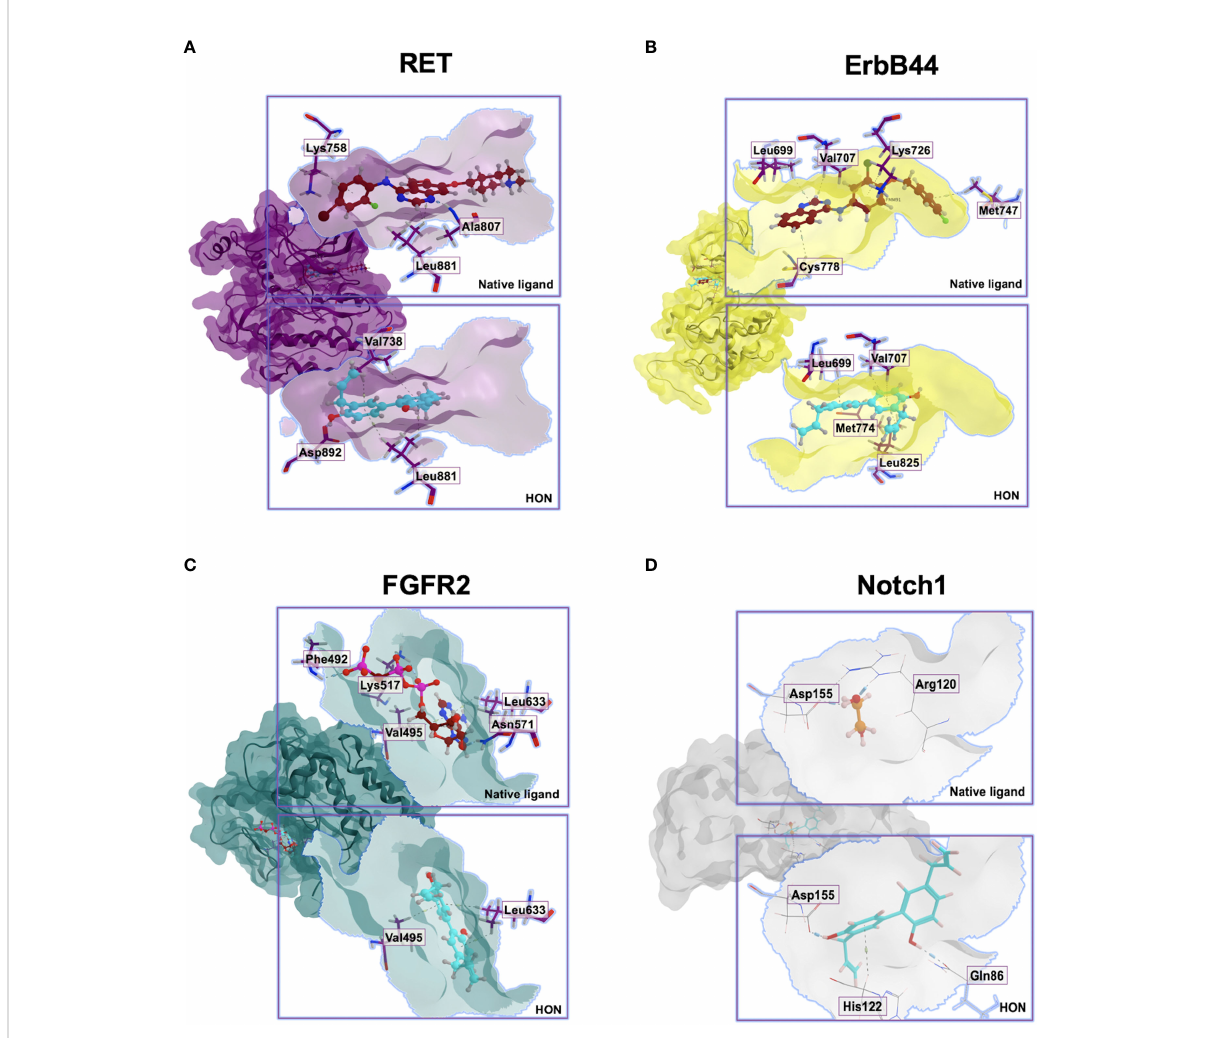
FIGURE 5 Molecular docking interactions between the (A) . RET, (B) . ErbB4, (C) . FGFR2, (D) . Ankyrin domain of Notch1, their native ligands, and